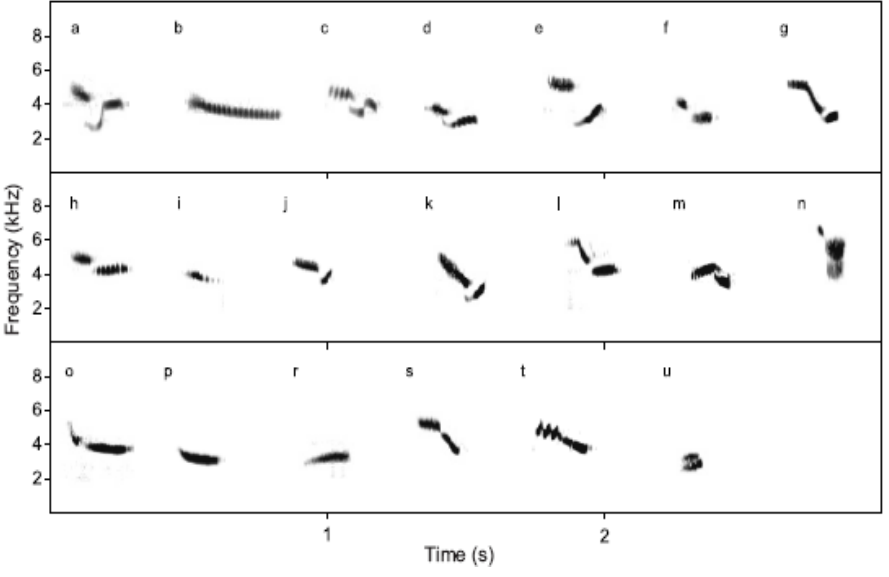
Figure 4. Ortolan bunting syllables (from